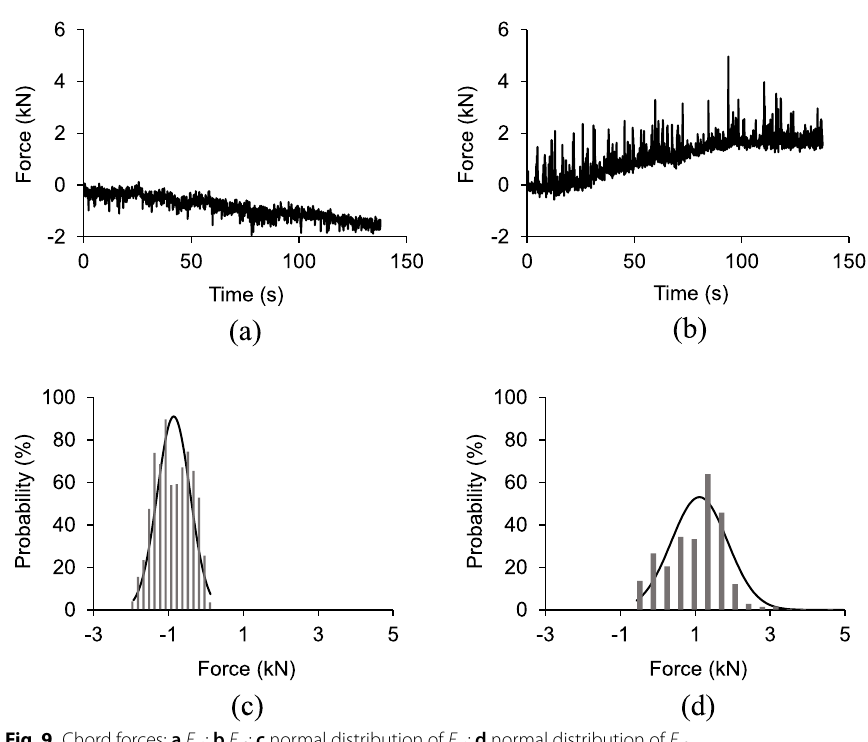
Fig. 9 Chord forces: a F t1 ; b F t2 ; c normal distribution of F t1 ; d normal distribution of F t2